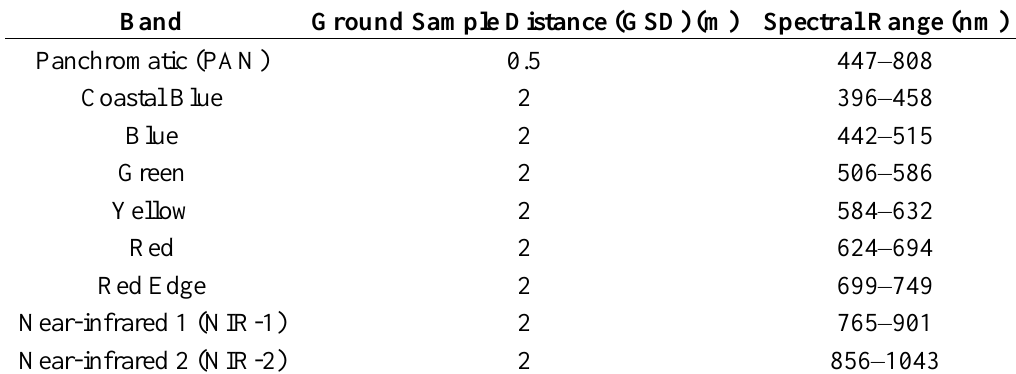
Table 1. Characteristics of the WorldView-2 image data [28].